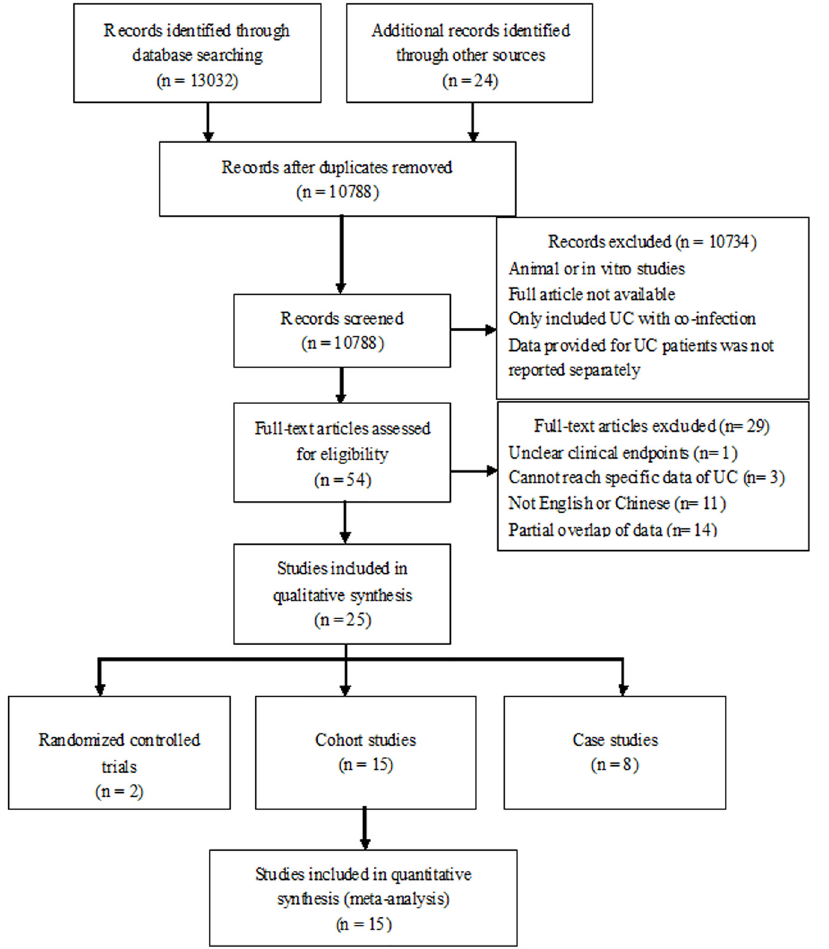
Fig 1. Flow chart of studies of fecal microbiota transplantation in ulcerative